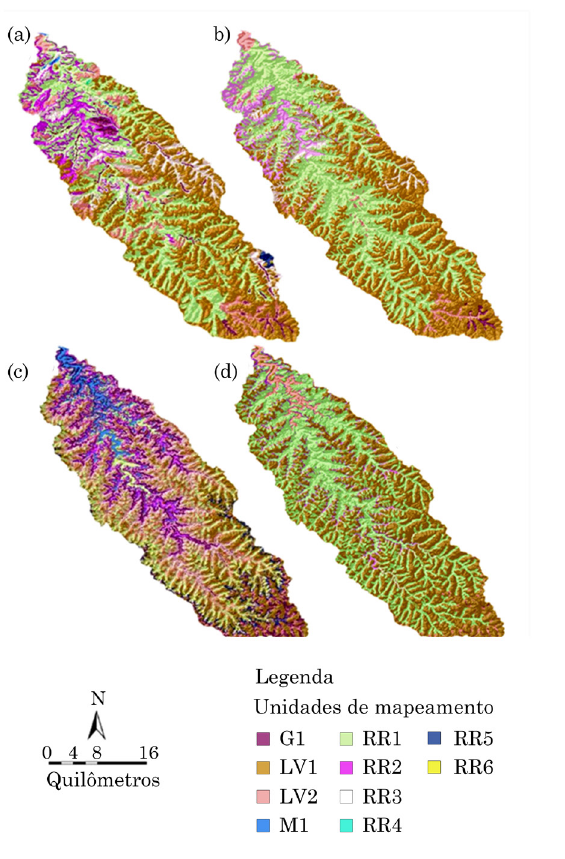
Figura 1. (a) mapa convencional de solos da bacia do Rio Santo Cristo (Kämpf et al., 2004); (b) mapa digital de solos com amostragem aleatória simples; (c) mapa digital de solos com amostragem estratificada); e (d) mapa digital de solos com amostragem proporcional à área de cada unidade de